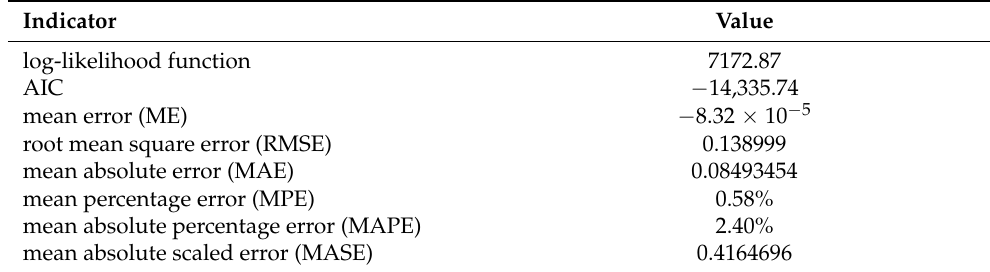
Table 1. Log-likelihood function, AIC, and error measures for the parameter estimation. Indicator log-likelihood